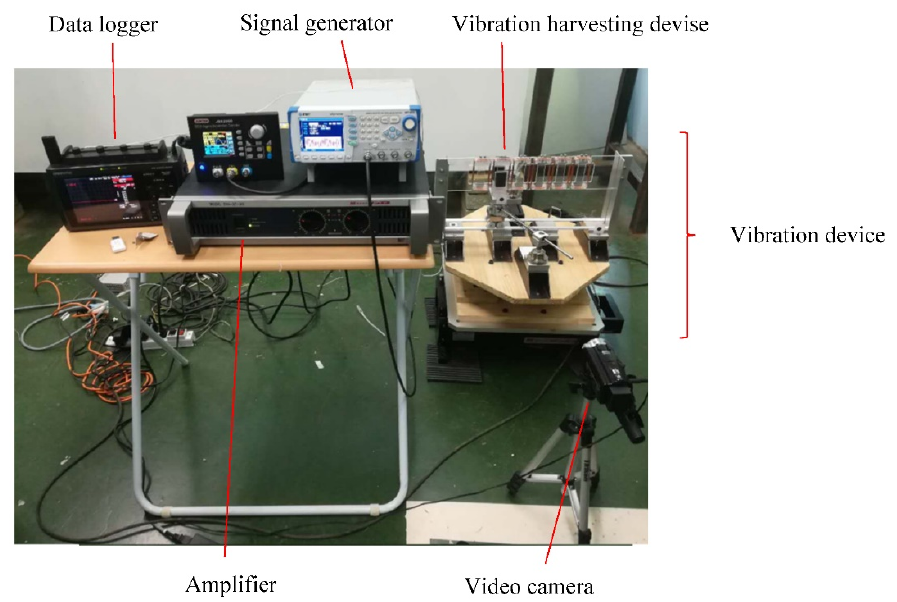
Figure 3. Experimental equipment for verification of bi-stable vibration harvesting system. Table 1. Settings of experimental system.